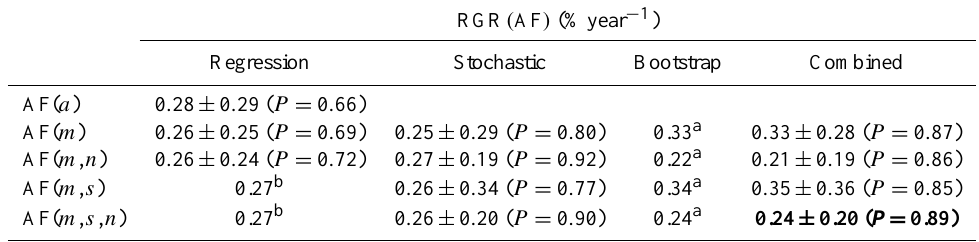
a The bootstrap trend estimation method does not return confidence intervals or P values. b For data treatments involving smoothing of monthly data, AF( m , s ) and AF( m , s , n ), regression yields spuriously small confidence intervals (not shown) because of temporal autocorrelation of time series. Table 2. Estimates of RGR (k S ) over 1959.0–2013.0, using Eq. (A2). Rows distinguish different data treatments, columns distinguish differ- ent trend estimation methods. Ranges are ± 1 σ confidence intervals. All P values (probability of negative trend) exceed 0.998 and are not shown. The best estimate, with P > 0 . 999, is shown in bold.